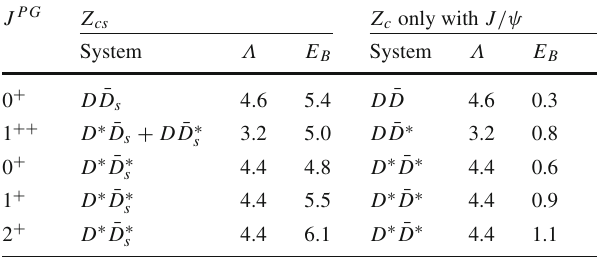
Table 4 The binding energies of some bound states with selected value ( ∗ ) of cutoff Λ . The result for the D ( ∗ ) ¯ D s systems are listed in the 2– 4th columns. The results for the D ( ∗ ) ¯ D ( ∗ ) only with J /ψ exchange are listed in 5–7th columns. The cutoff Λ and binding energy E B are in the units of GeV and